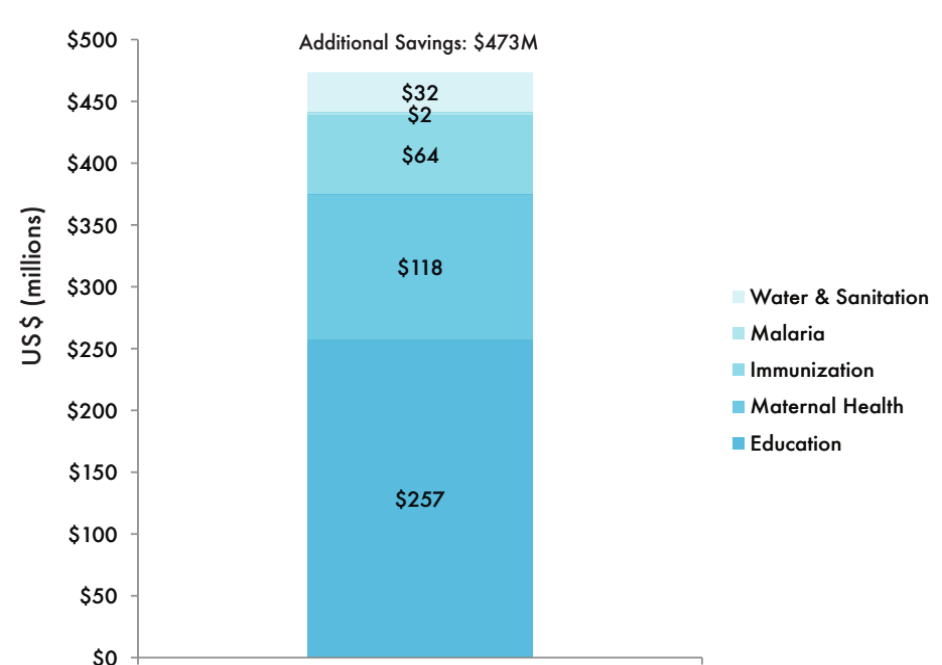
Figure 6: Social Sector Savings in Zimbabwe,